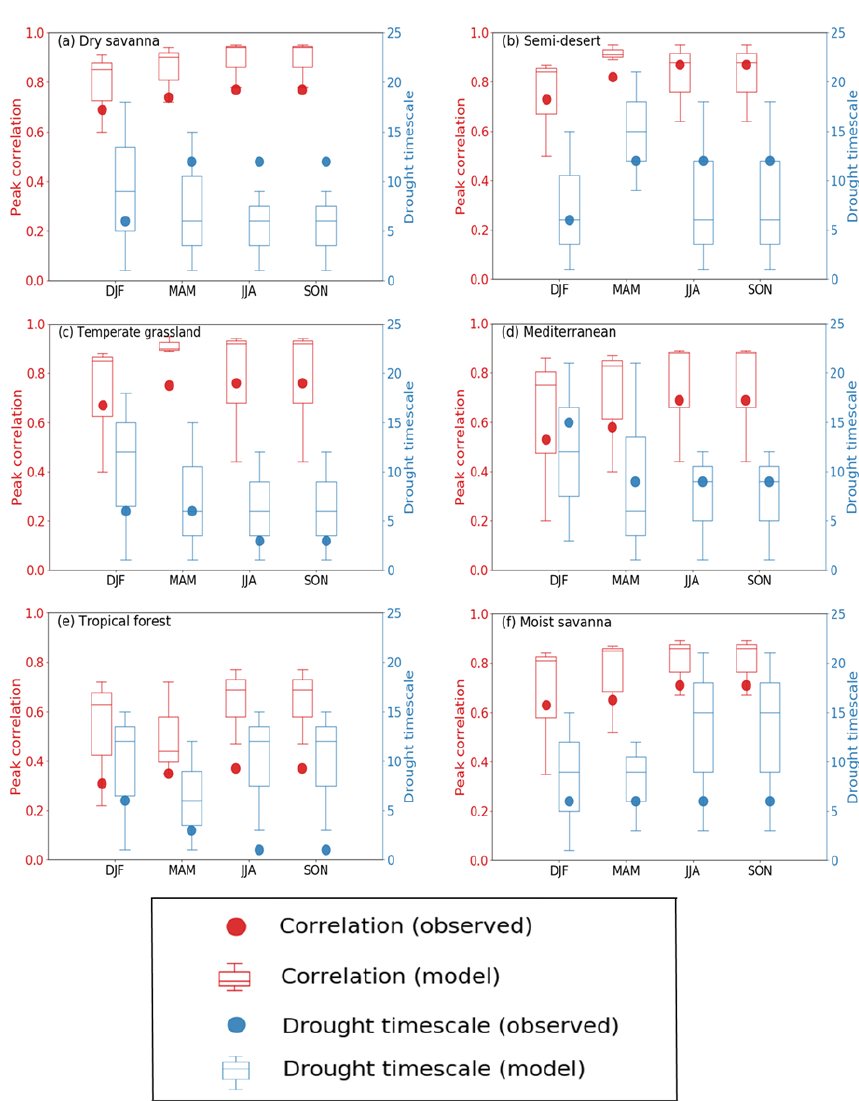
Figure 9. Seasonal correlations of drought (SPEI) and LAI across six southern African biomes. The values on the left axis show the peak correlation in observation and TRENDY models. The values on the right axis indicate the corresponding drought